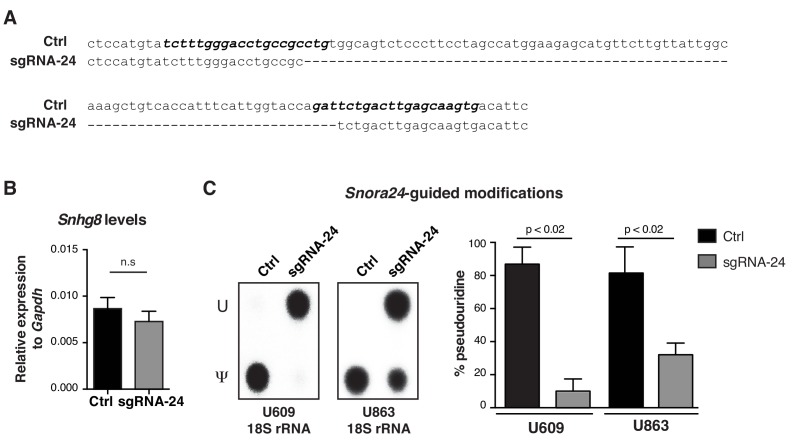
Reduction of Snora24-guided modifications in mouse KrasG12D liver cancer cells using CRISPR-Cas9 gene editing.(A) The mouse Snora24 gene sequence is shown (Ctrl) aligned to the sequence of the Snora24 gene upon generating an 81 nucleotide deletion following CRISPR-Cas9 gene editing in KrasG12D HCC cells (sgRNA-24). The binding sites of the sgRNAs used to target mouse Snora24 are highlighted in bold and italics. (B) qPCR analysis of Snhg8 in Ctrl KrasG12D and sgRNA-24 KrasG12D HCC cells. Graph shows mean relative expression ± SD normalized to the levels of Gapdh from three independent experiments. Statistical analysis was performed using an unpaired Student’s t test, n.s = non significant. (C) Representative TLC of site-specific amounts of pseudouridine (Ψ) or uridine (U) present at position U609 and U863 on 18S rRNA using SCARLET in Ctrl KrasG12D and sgRNA-24 KrasG12D HCC cells (left panel). Quantification of TLC showing the percentage pseudouridine at position U609 (left) and U863 (right) on 18S rRNA using SCARLET in Ctrl KrasG12D and sgRNA-24 KrasG12D HCC cells. Graph shows mean ± SD percentage pseudouridine for the indicated residue from three independent experiments. Statistical analysis was performed using an unpaired Student’s t-test, p<0.02 (right panel).